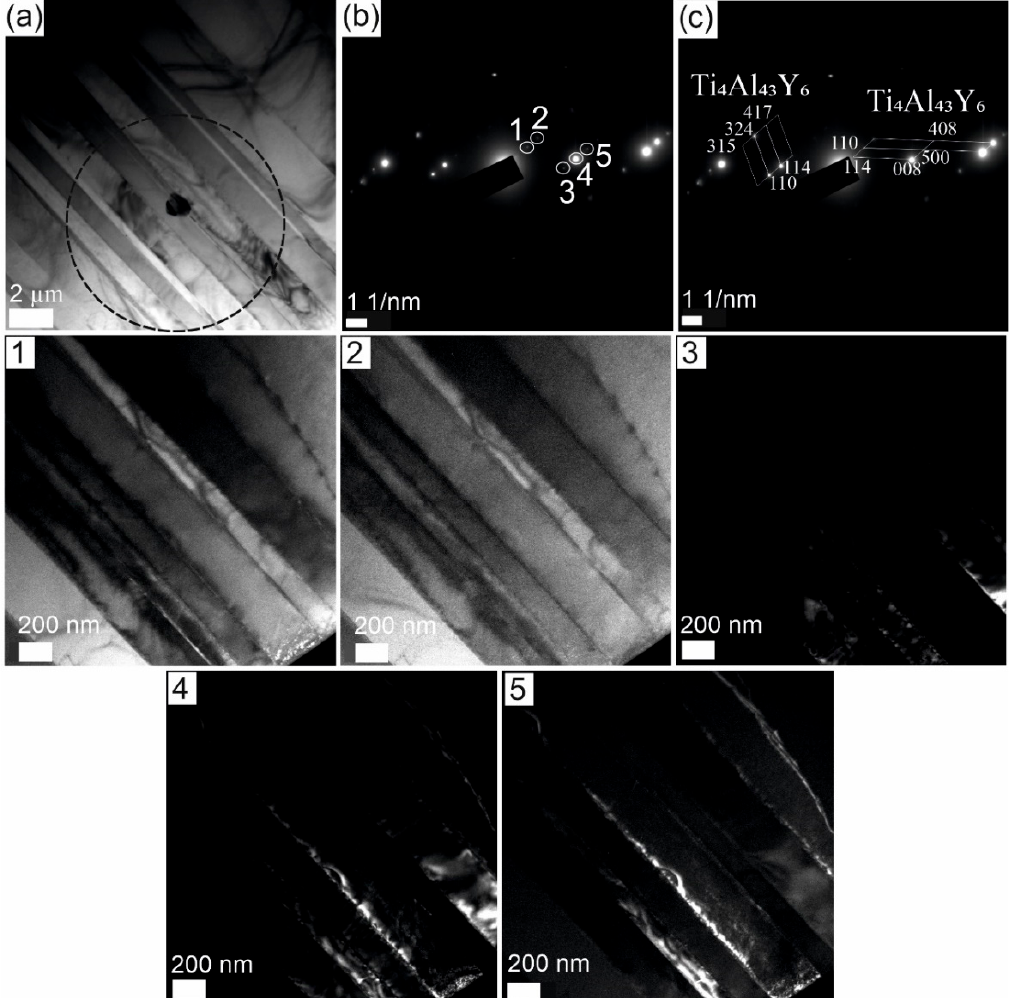
Figure 3. BF images of the Ti-Al-Y alloy ( a ), SAED pattern ( b ) of the Ti-Al-Y alloy with the bright image. SAED patterns of the Ti-Al-Y alloy in the relevant region ( c ). The dark-field images (1)–(5) correspond to reflexes (1)–(5) in the microdiffraction pattern ( b ). Table 1. Summary table of the results of the EDS. No. of Spectrum